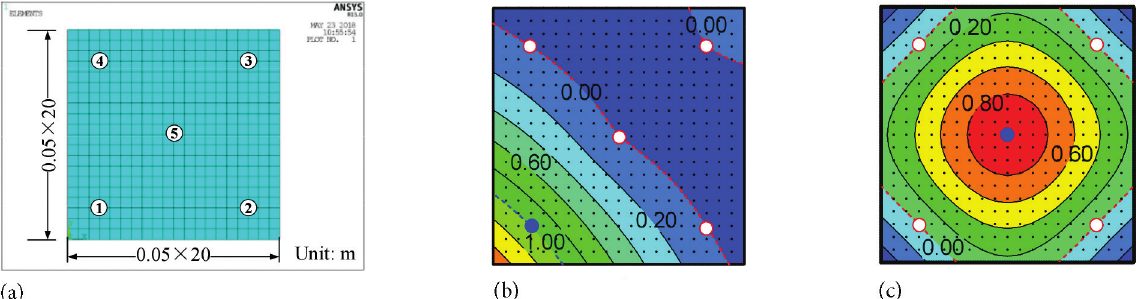
Figure 9. Finite element model and contour map of numerical shape function: a – finite element model; b – shape function N 1 ; c – shape function N